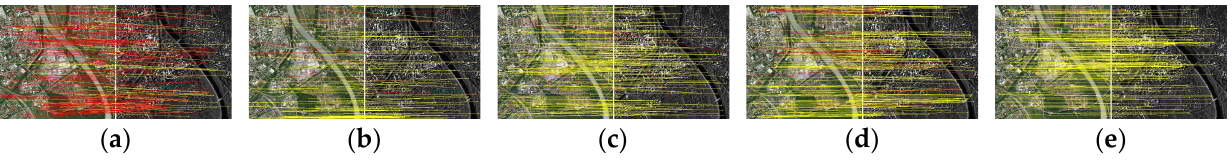
Figure 6. Matching results of pair A. ( a ) Contextdesc; ( b ) R2D2; ( c ) D2-Net; ( d ) ASLFeat; ( e ) PM-Net. Yellow lines represent correct matches and red lines represent false matches. Figure 7. Matching results of pair B. ( a ) Contextdesc; ( b ) R2D2; ( c ) D2-Net; ( d ) ASLFeat; ( e ) PM-Net. Figure 8. Matching results of pair C. ( a ) Contextdesc; ( b ) R2D2; ( c ) D2-Net; ( d ) ASLFeat; ( e ) PM-Net. Figure 9. Matching results of pair D. ( a ) Contextdesc; ( b ) R2D2; ( c ) D2-Net; ( d ) ASLFeat; ( e ) PM-Net. Figure 10. Matching results of pair E. ( a ) Contextdesc; ( b ) R2D2; ( c ) D2-Net; ( d ) ASLFeat; ( e ) PM-Net. Figure 11. Matching results of pair F. ( a ) Contextdesc; ( b ) R2D2; ( c ) D2-Net; ( d ) ASLFeat; ( e ) PM- Net.